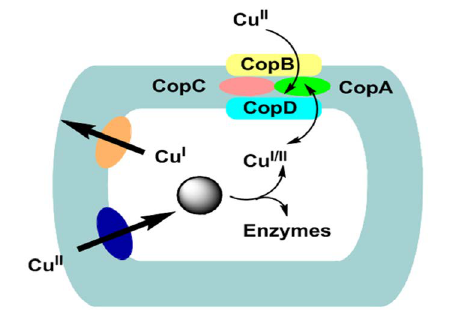
Fig 2. Copper transport, hypothesized CutU (uptake) and CutE (efflux) P-type ATPases model in Gram-positive bacteria